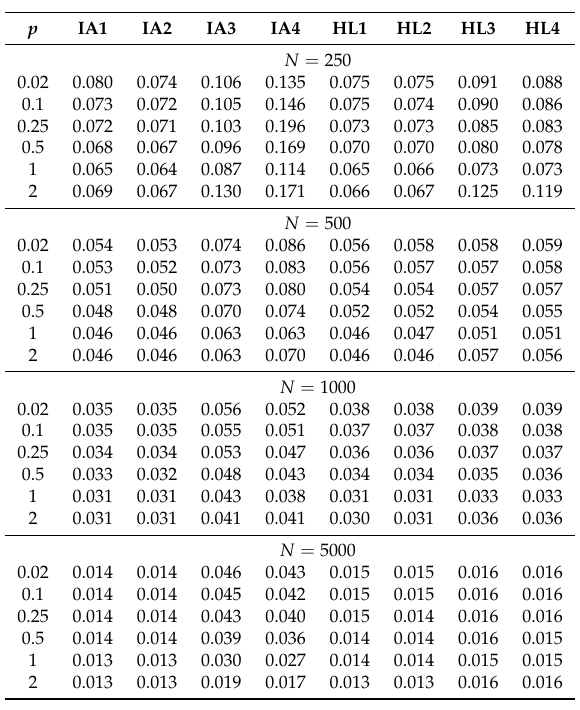
Table A2. Simulation Study 2: Average Root Mean Square Error (ARMSE) of Group Means as a Function of Sample Size in the Condition of No Differential Item Functioning (No DIF) and G = 6 Groups.